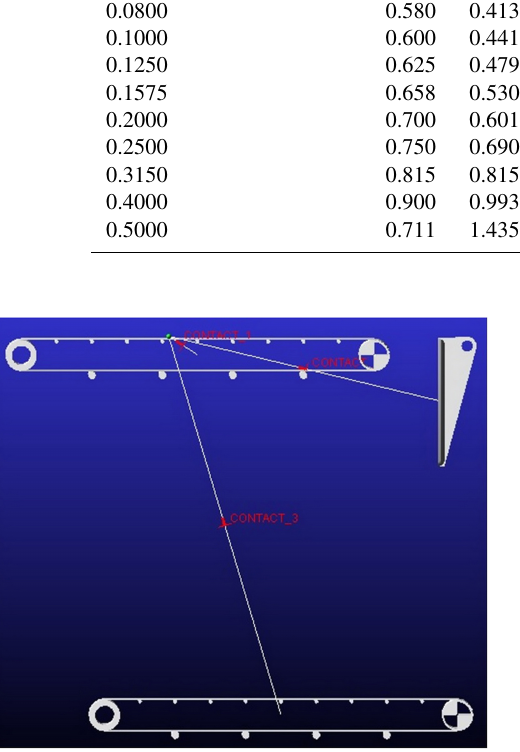
Figure 10. View of re-direction model in the ADAMS